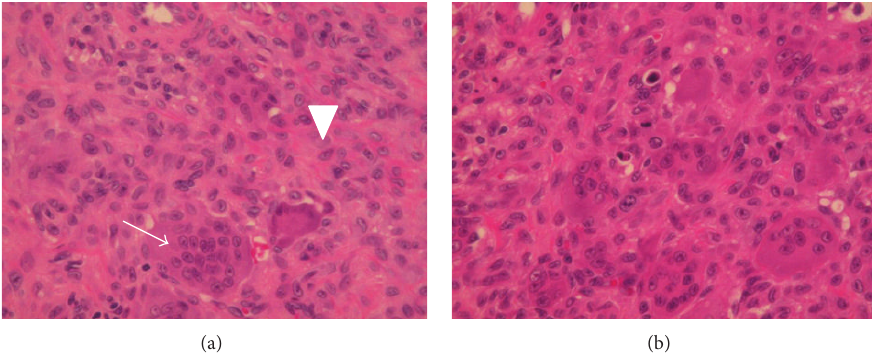
Figure 4: (a) Histological examination demonstrates that the cellular mononuclear eosinophilic stromal component (arrowhead) and multinucleated osteoclast-like giant cells (arrow) were scattered throughout the lesions in an intermediate power field. Pleomorphic giant cells are absent. (b) Mitotic figures are about 6/10 HPF by the lack of cytological